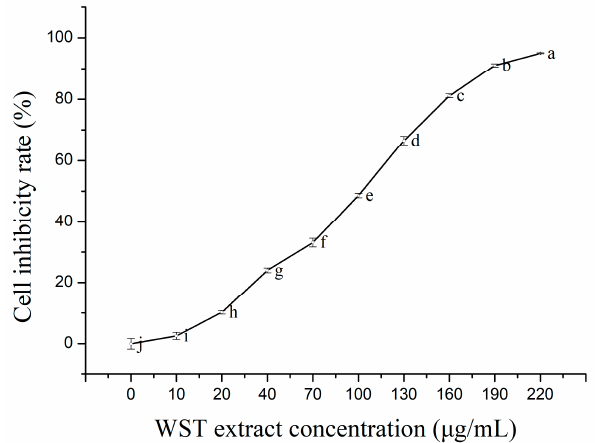
Figure 2. Growth inhibition of human hepatoma HepG2 cells treated with WST extract as evaluated using MTT assays. a–j Mean values with different letters in the same bar graph are significantly different ( p < 0.05) according to Duncan’s multiple range test. Appl. Sci. 2019 , 9 , x FOR PEER REVIEW